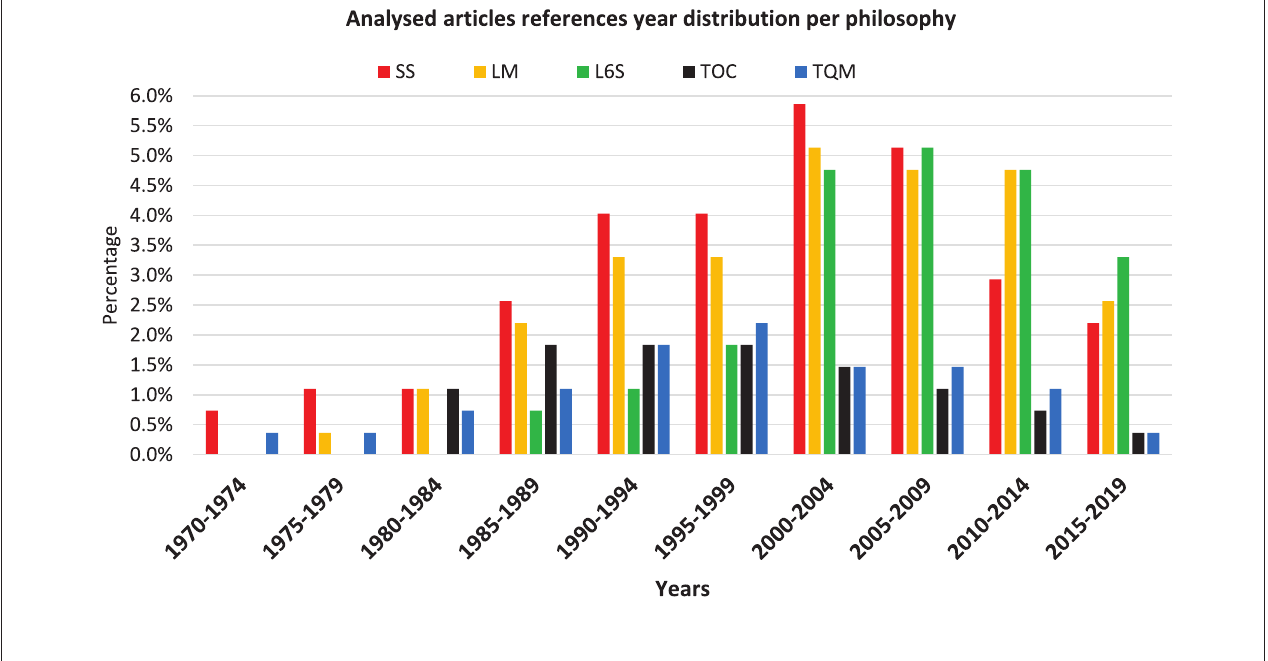
FIGURE 2 | Distribution of the references mentioned in the reviewed papers through